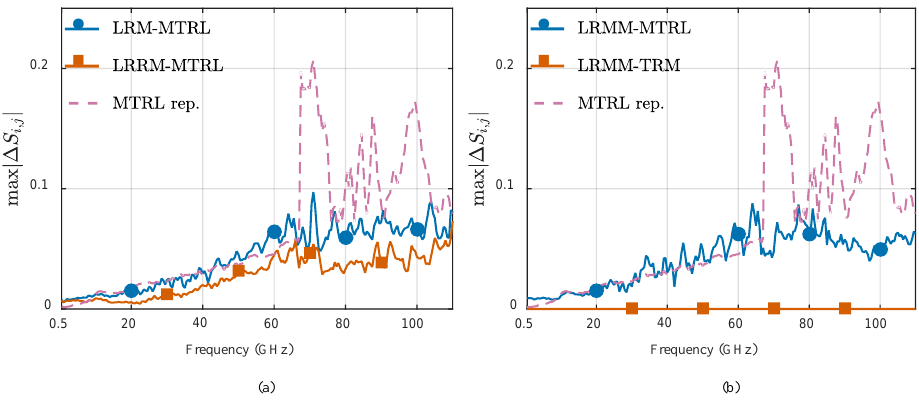
Figure 6. Calibration comparison results for ( a ) LRM and LRRM and ( b ) LRMM and thru-reflect-match (TRM). “MTRL rep.” denotes the repeatability error of MTRL calibration.